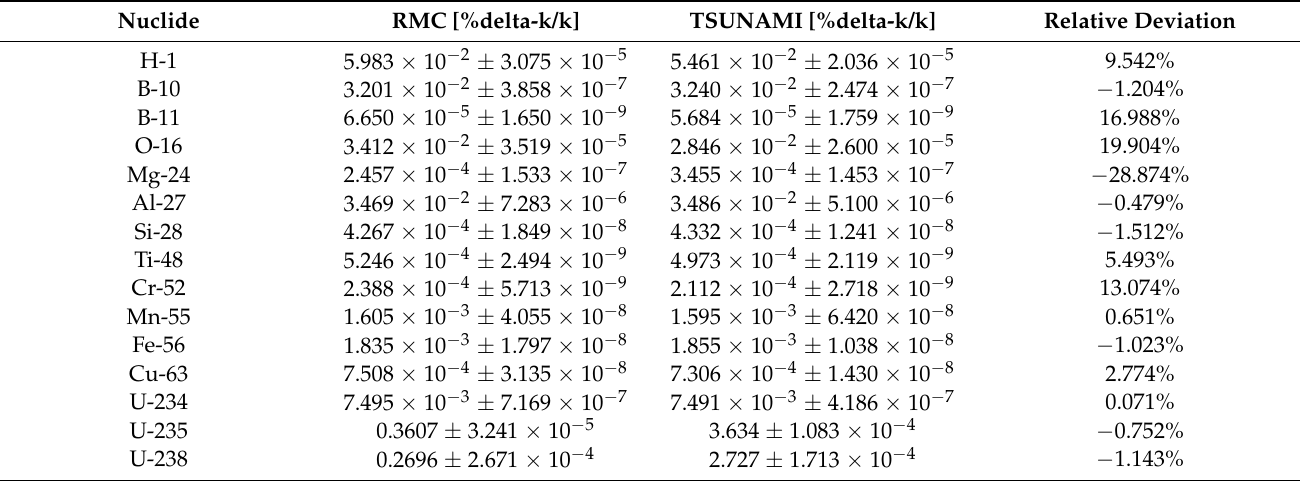
Table 9. Uncertainty of nuclides (SCALE 44-group covariance library).